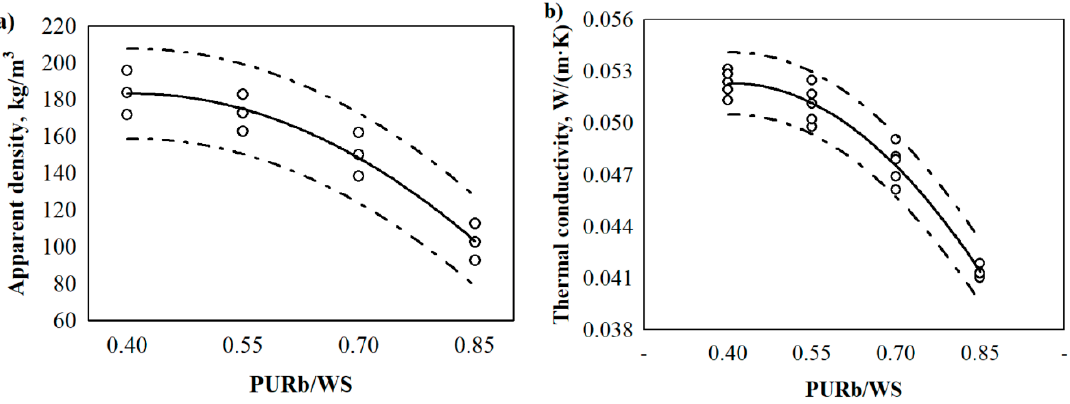
Figure 5. The changes of physical properties of PUR biocomposite foams with different PURb/WS ratios: ( a ) apparent density, ( b ) thermal conductivity. WS—cleaned sawdust, o—single values from respective property measurements.